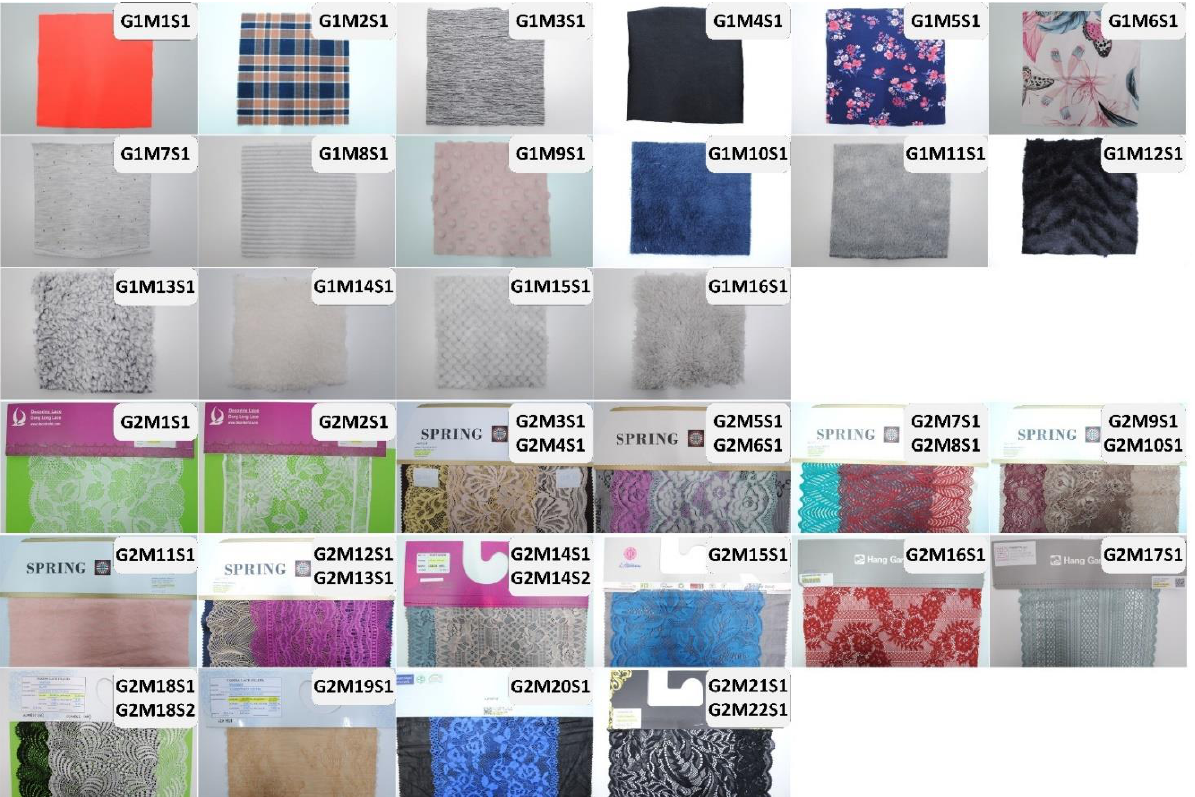
Figure 4. Test samples of the main experiment. Table 2. Set of material samples for main experiment.